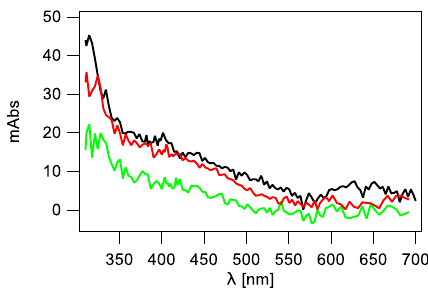
Figure 4. Transient absorption spectra recorded using ICCD ( − ) 1 µ s, ( − ) 50 µ s, and ( − ) 1 ms after electron pulse in N 2 O-saturated phosphate buffered (50 mM) aqueous solutions containing mixture of 2′ -deoxyguanosine (dG, 0.5 mM) and 2′ -deoxycytidine (dC, 0.5 mM) with concentration ratio 1:1 at pH 7.